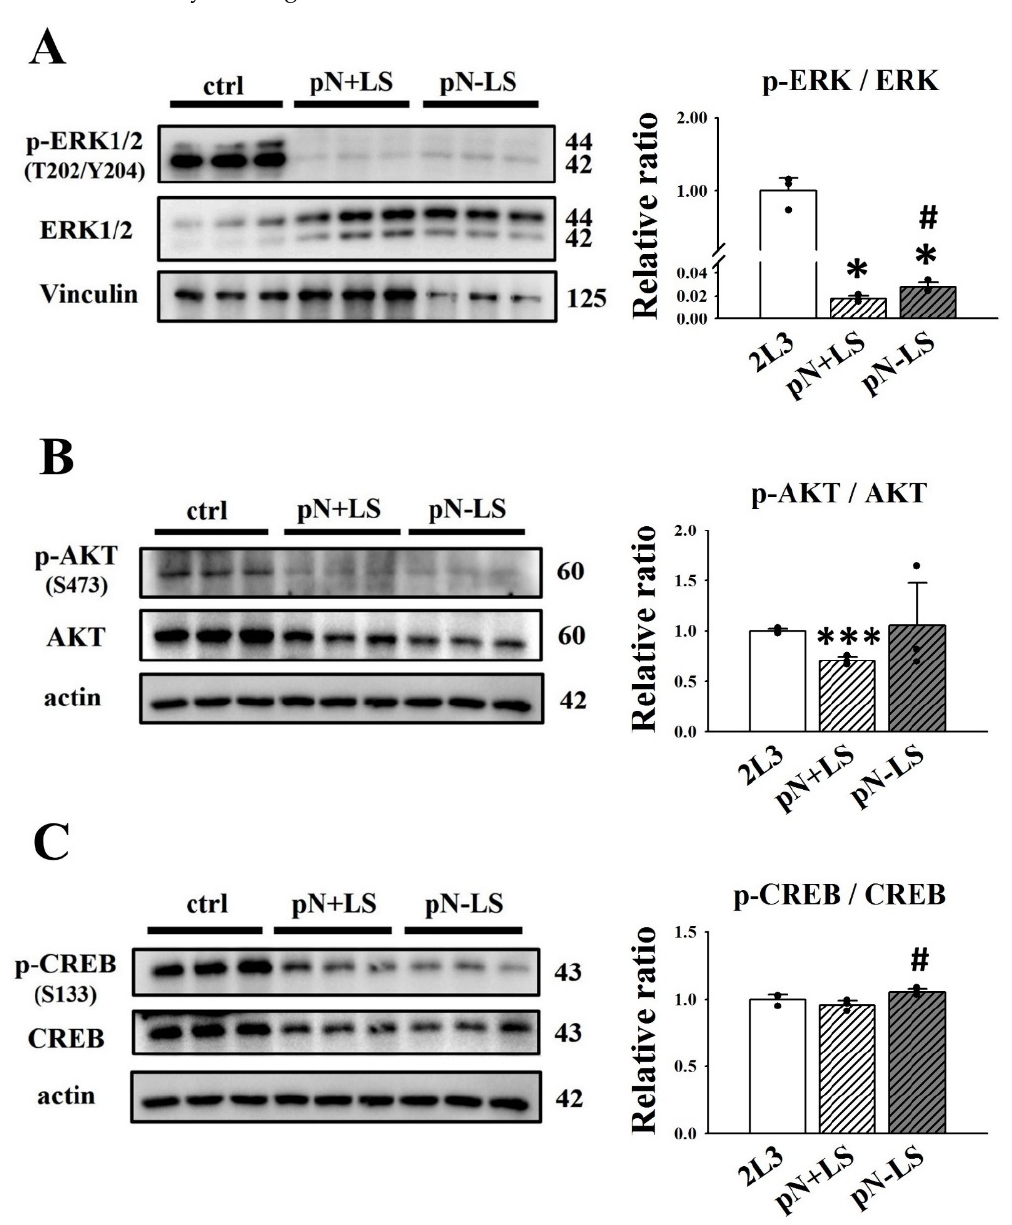
lower percentages of large (diameter > 100 µ m) cysts than the control group (Figure 10F) from Days 4 to 8. These results showed that pN + LS and pN − LS both inhibited cyst enlargement, while the inhibitory effect of pN − LS was weaker than that of pN + LS. This finding revealed that overexpression of secreted mNGAL had a superior ability to inhibit cyst enlargement of 2L3 cells in 3D culture than nonsecreted mNGAL.